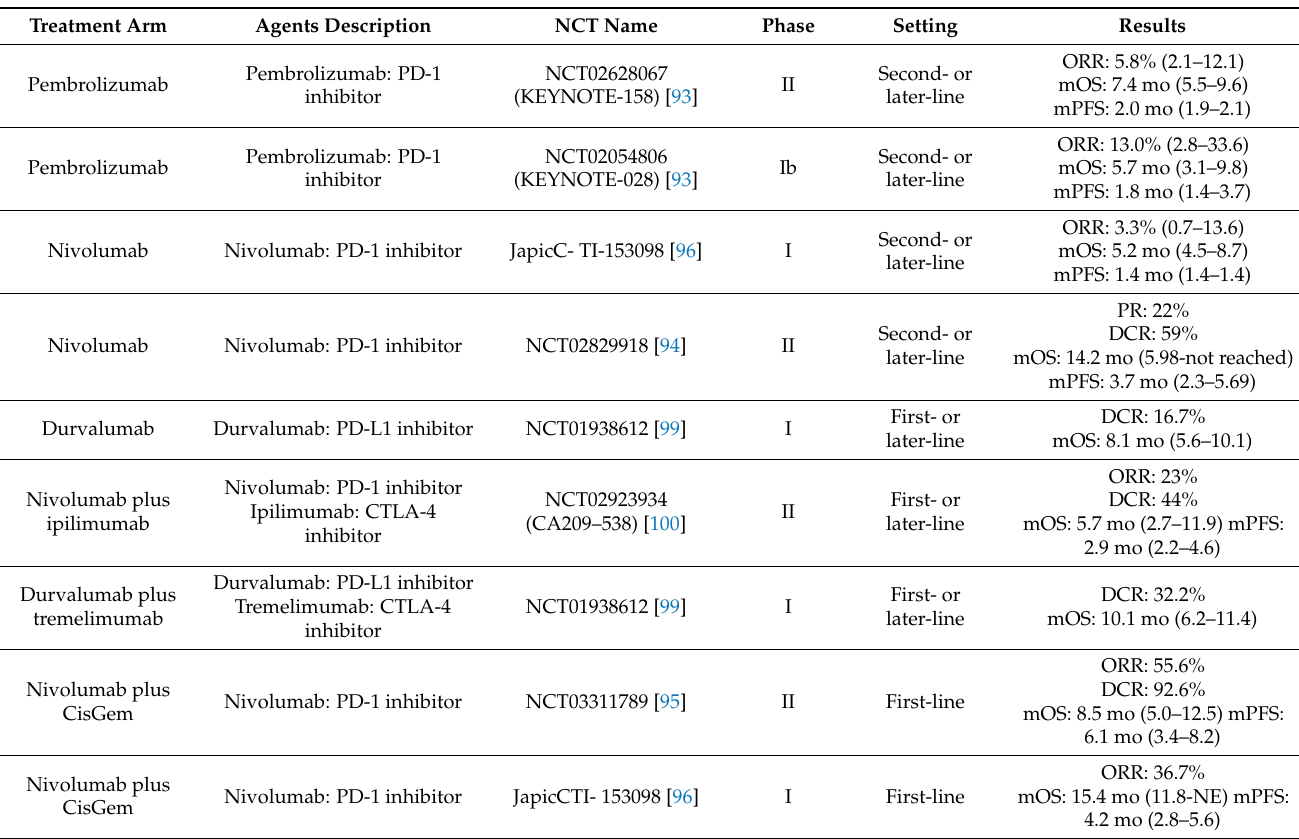
Table 3. Summary of main clinical trials evaluating immune checkpoint inhibitors in biliary tract cancer patients with advanced